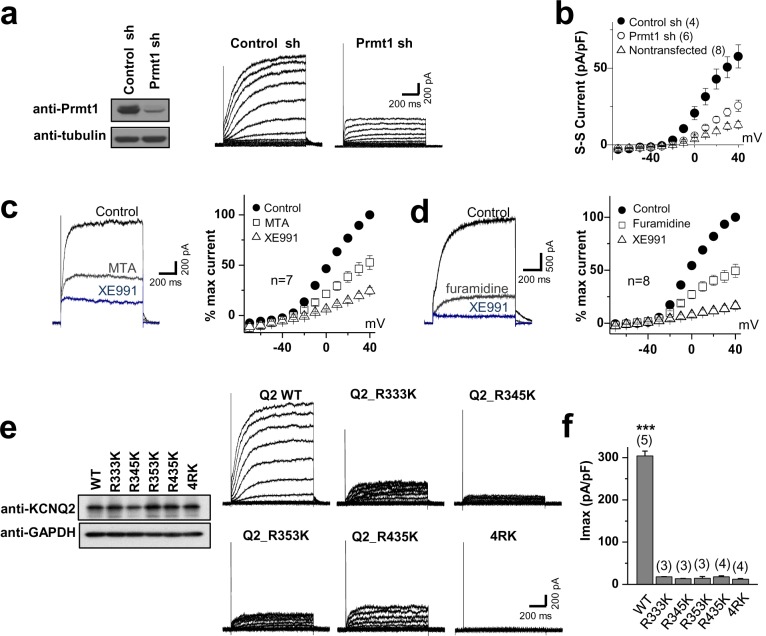
Methylation of KCNQ2 regulates its channel activity.(a) Representative current recordings from HEK293T cells expressing KCNQ2 with control shRNA vector (left) or a Prmt1 shRNA (Prmt1 sh) (right). Currents were elicited by voltage steps from -70 mV to +40 mV with a subsequent step to -60 mV. (inset) Control immunoblotting for Prmt1 expression. (b) I-V relationships in control cells (●) or Prmt1 knockdown cells (○) or nontransfected cells (△) are shown. (c–d) Treatment of MTA (c) or furamidine (d) induces a reduction of KCNQ2 currents (left). Both of them suppress KCNQ2 currents without altering shape of I-V curves (right). XE991, KCNQ channel blocker. (e) Representative current recordings from cells expressing WT and methylation defective mutants. (inset) The control western blot shows the expression of various KCNQ vectors. (f) The current density of KCNQ2 at +40 mV for each mutant shown in e. ANOVA Tukey test, ***p<0.001.DOI:
http://dx.doi.org/10.7554/eLife.17159.02010.7554/eLife.17159.021Figure 6—source data 1.Source data for Figure 6.